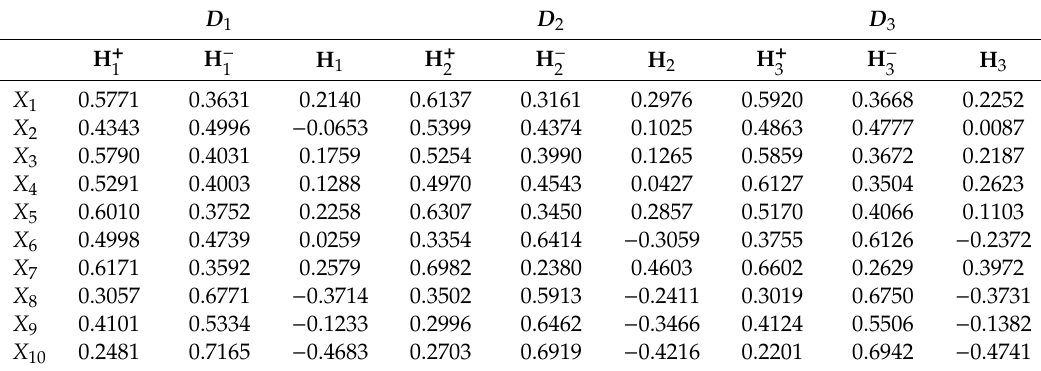
Table A15. The positive, negative and net flow of X v for D 1 , D 2 , D 3 based on UMLDM-EW.